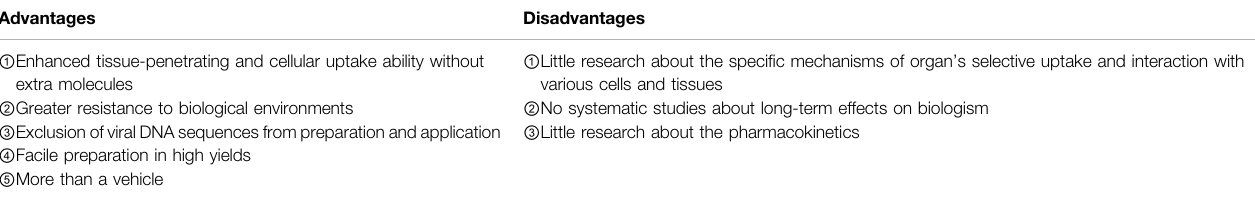
TABLE 1 | The advantages and disadvantages of tFNA-based nanomaterials used in biomedical fi elds. Advantages